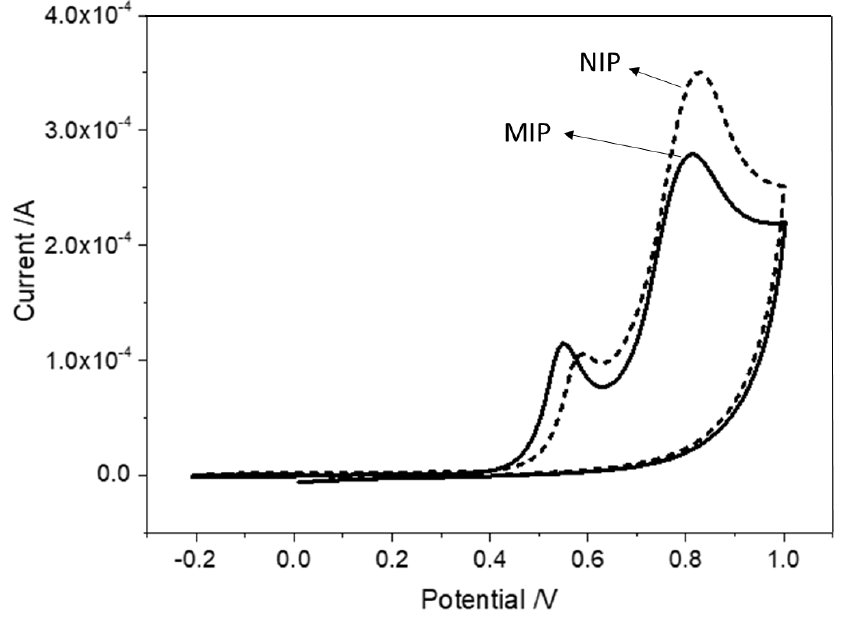
Figure 2. Typical CV voltammograms obtained for of electropolymerization of Py monomer (C = 10 mmol L − 1 , in 0.1 mol L − 1 PBS at pH 7.2) at the (―) MIP and ( ---) NIP surfaces. Number of cycles: 1. Scan rate: 100 mV·s −1 .